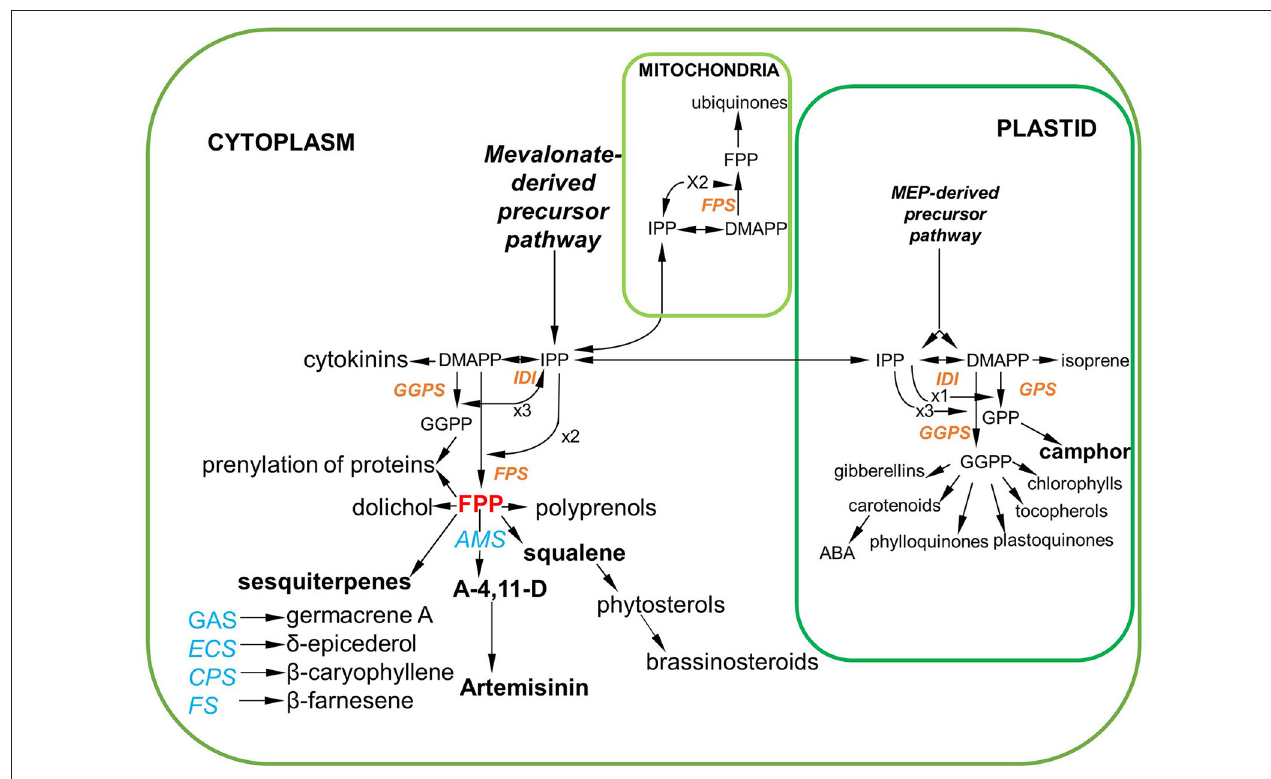
FIGURE 1 | Summary of sesquiterpene production in Artemisia annua via the mevalonate (MVA) pathway in the cytosol FPP is highlighted as the key precursor not only for artemisinin synthesis but also for Squalene and other sequiterpenes. The plastidial methyl erythritol phosphate (MEP) pathway that leads to monoterpene production is also included. enzymes in red have been cloned from A. annua and the sesquiterpene synthases and squalene synthases also cloned from A. annua are in blue (DMAPP, dimethylallyl diphosphate; GGPP, geranyl geranyl diphosphate; GPP, geranyl pyrophosphate; GGPS, geranylgeranyl pyrophosphate synthase; IPP, isopentenyl diphosphate; IDI, isopentyl diphosphate isomerase; ABA, abscisic acid; FPS, farnesyl diphosphate synthase ; FPP, farnesyl pyrophosphate; AMS, amorpha-4,11-diene synthase; SQS, squalene synthase; GAS, germacrene A synthase; ECS, δ -epicederol synthase; CPS, caryophyllene synthase; FS, beta farnesene synthase)